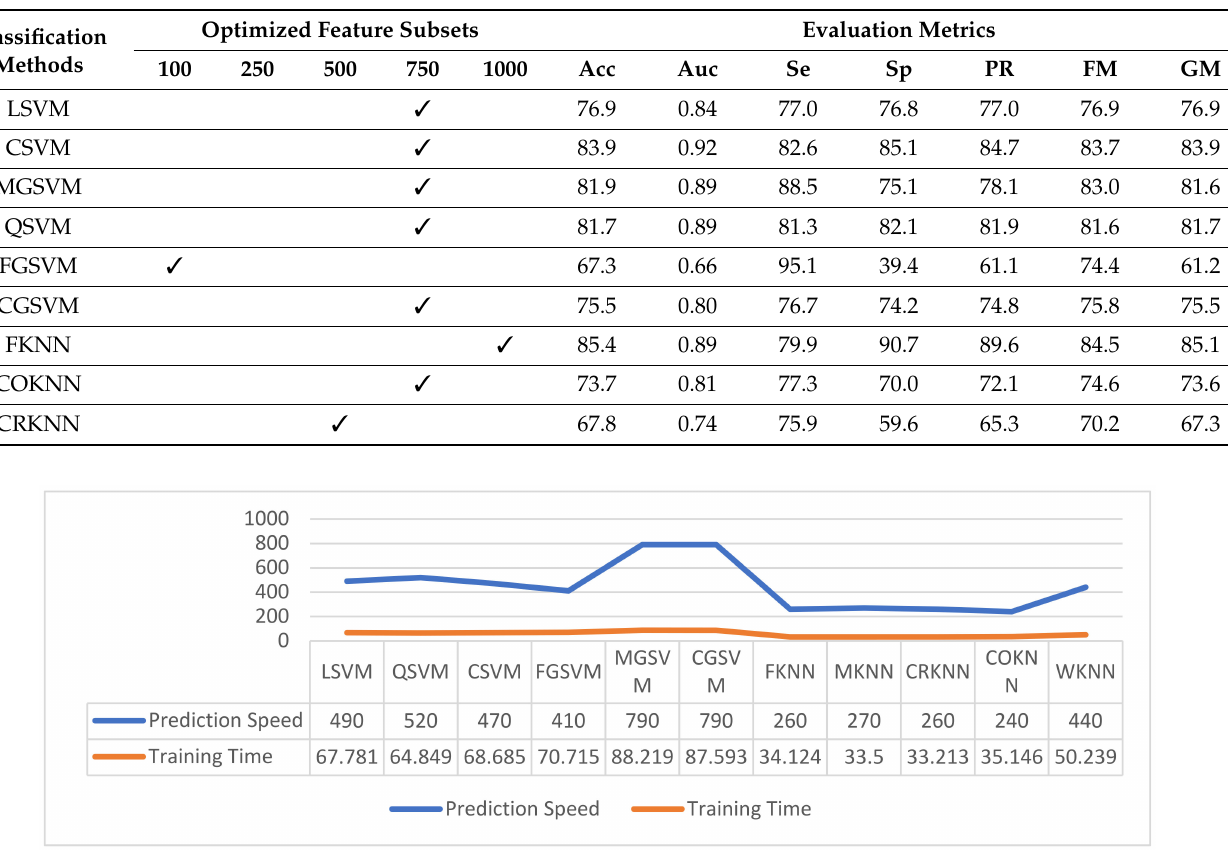
Table 8. The training time and prediction speed of proposed model on mixed views of MIT dataset are presented in Figure 8. Table 8. Mixed view-based experimental results on MIT dataset.